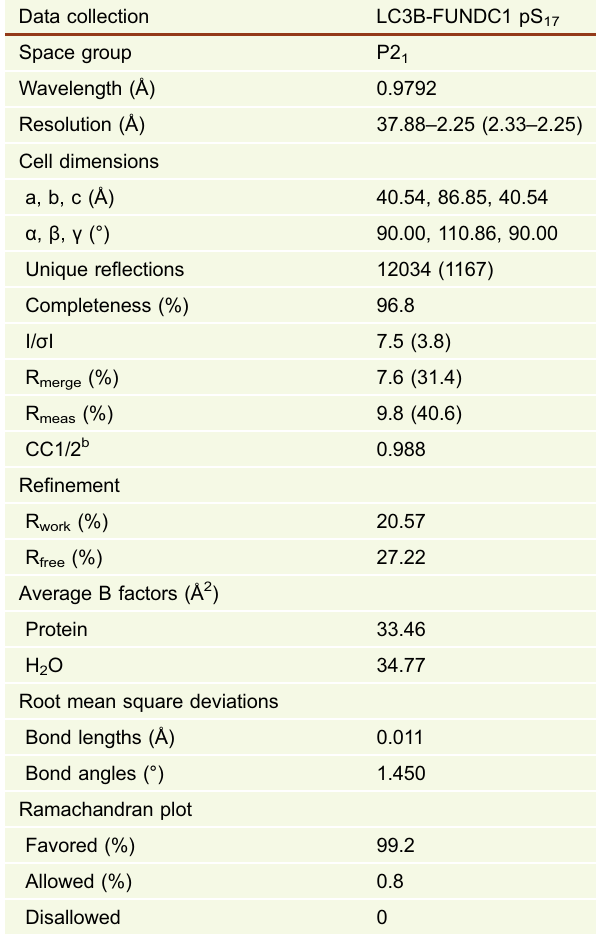
Table 1. Data collection and re fi nement